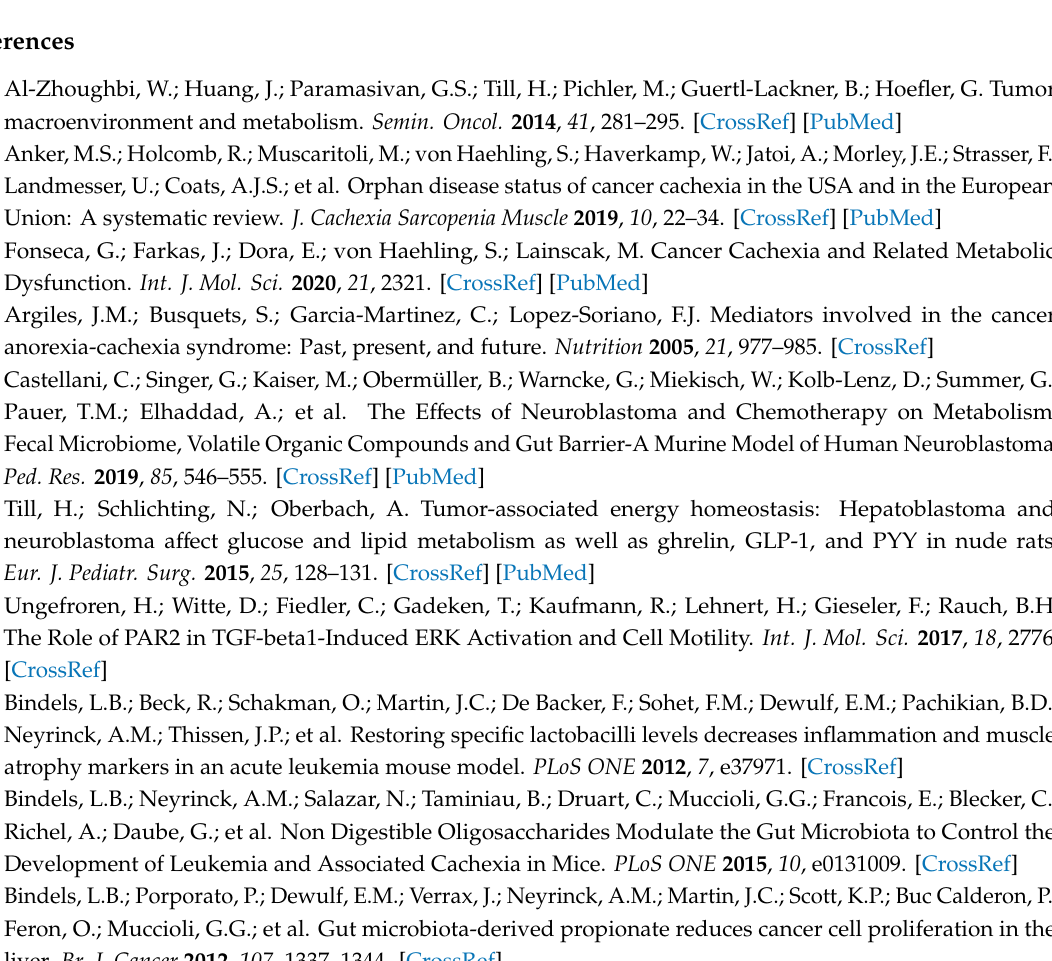
Figure S1: Pairwise comparison of markers for beta diversity. (a) E ff ect of POS, (b) tumor e ff ect and (c) e ff ect of OMNi-LOGiC ® FIBRE in tumor mice, Table S1: Correlation analysis between microbiota and fecal ethanol levels, Table S2: Correlation analysis between fecal VOCs, liver weight, and muscle weight, Table S3: Correlation between fecal VOC levels, food intake, weight gain, and total WAT, Table S4: Correlation between fecal VOCs, inflammatory cytokines, and FITC